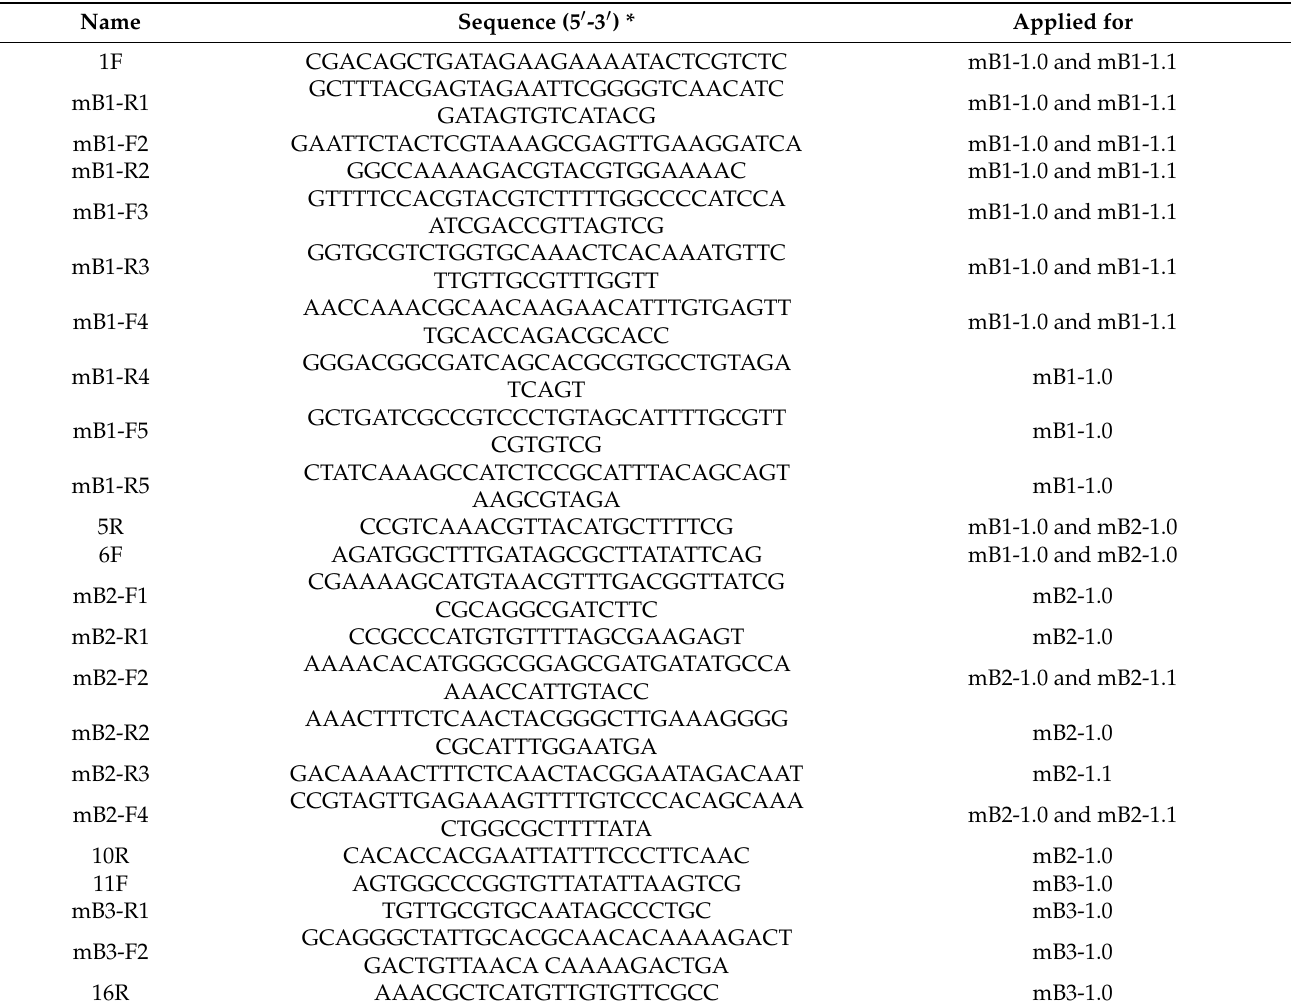
Table 1. Primers used in this